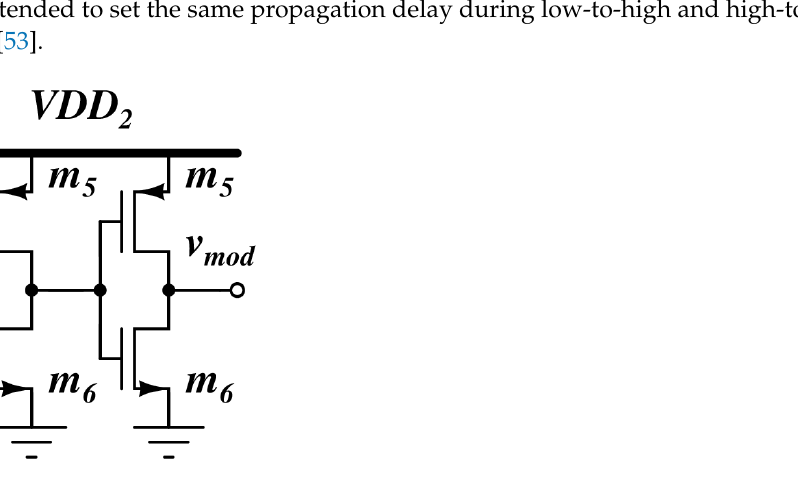
Figure 4. Voltage buffer used between the temperature sensor and the ASK backscatter